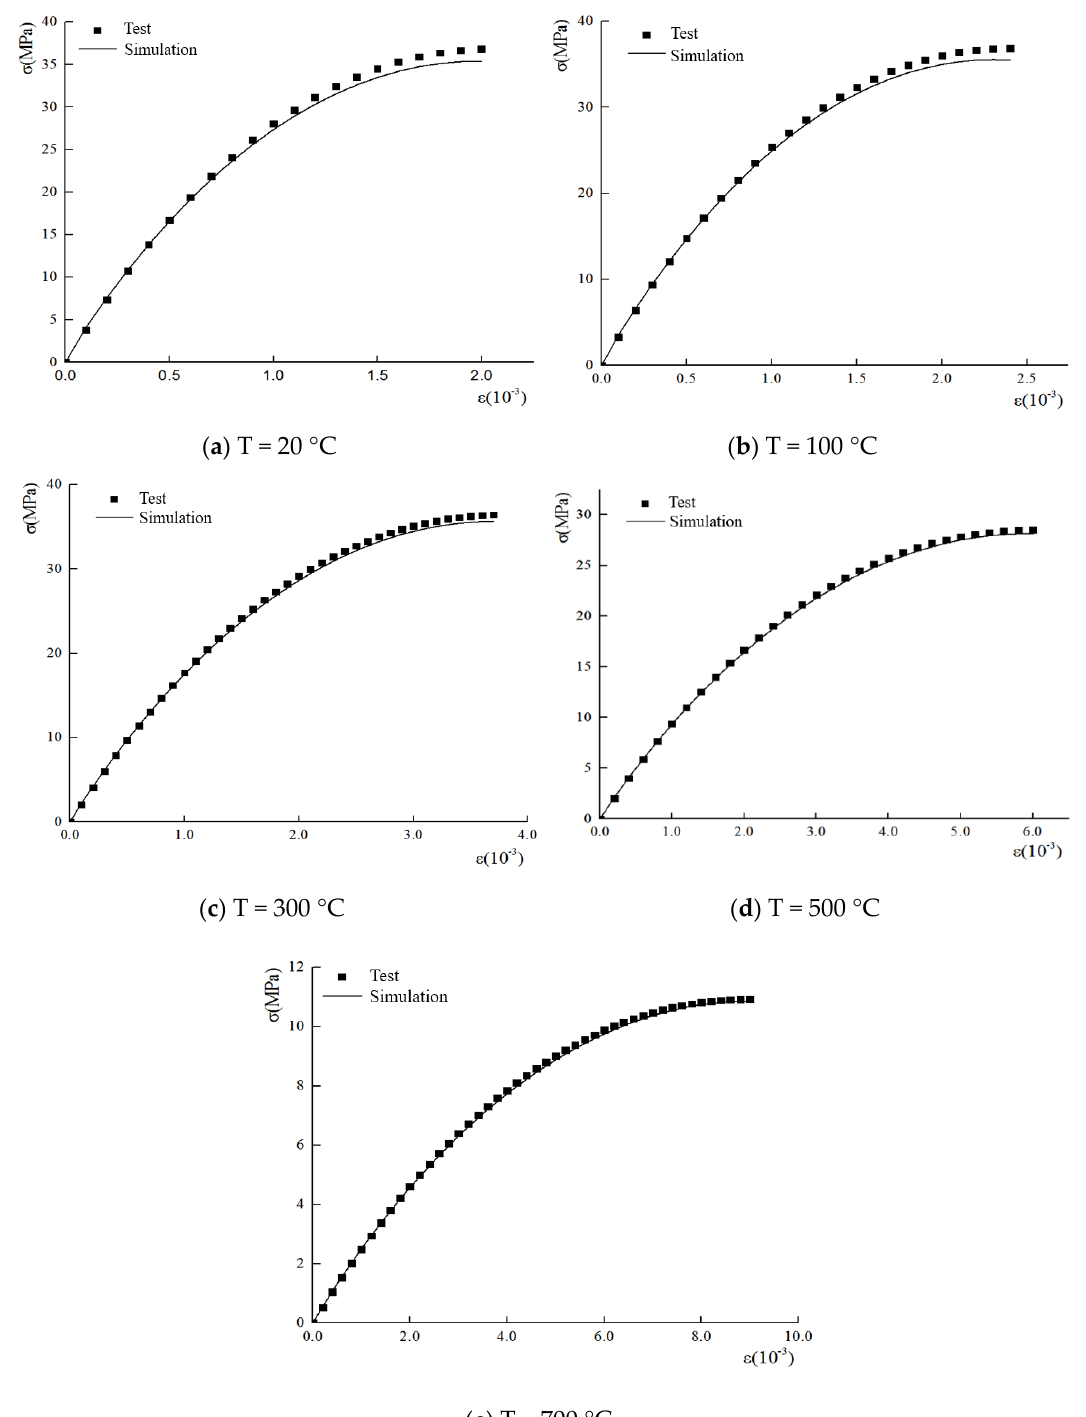
Figure 3. Comparison of simulation results and test results for C20 concrete.